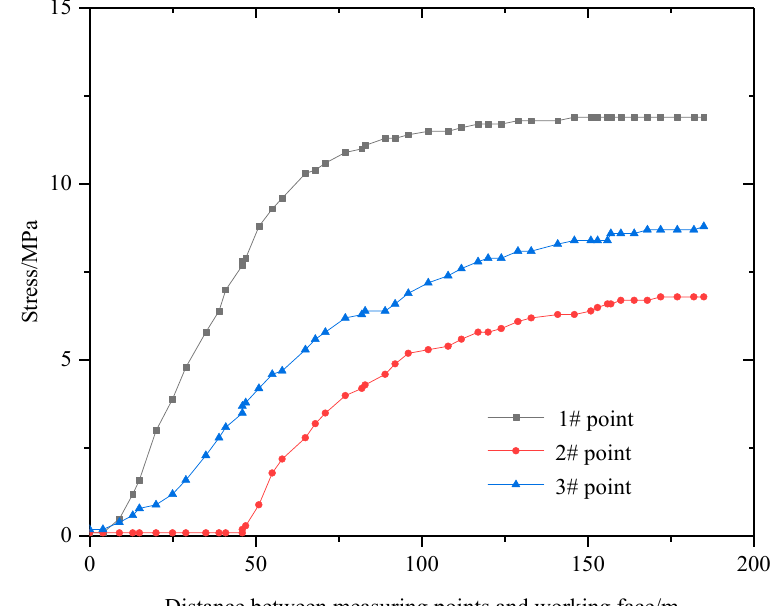
Figure 15. Filling body stress of the gob.